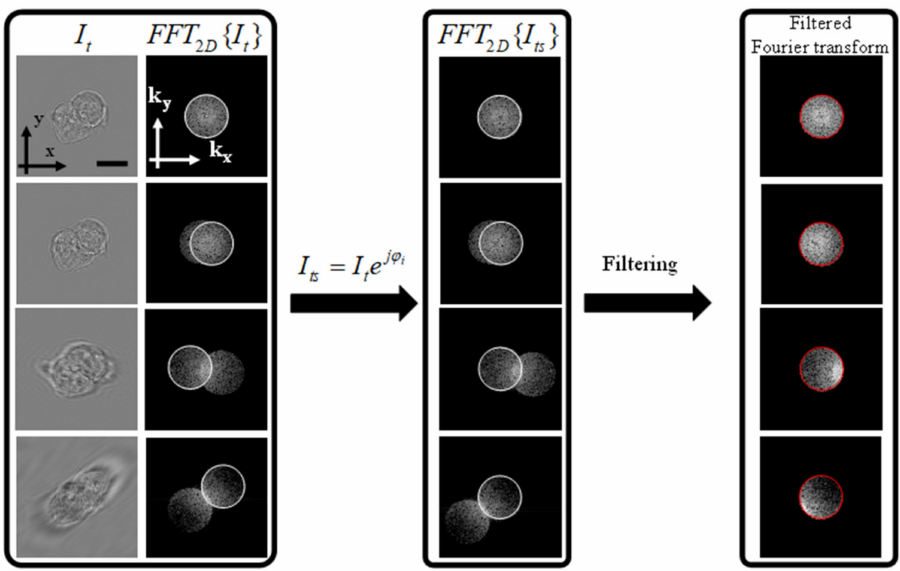
Figure 2. Processing of the 2D intensity images before mapping into the 3D Fourier space. The left- most panel shows the intensity measurements and the corresponding Fourier transform. The middle panel shows the effect of multiplying by the incident plane wave, which results in centering the scattered field highlighted by the white circles. The final step is the filtering of the scattered field with a circular filter whose size matches the size of the numerical aperture in the Fourier space declared by the red circle. Scale bar = 8 µ